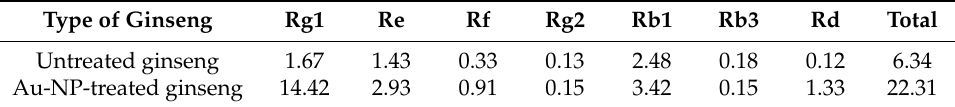
Table 1. Saponin contents in Au-NP-treated ginseng or untreated ginseng controls. Type of Ginseng Rg1 Re Rf Rg2 Rb1 Rb3 Rd Total Untreated ginseng 1.67 Au-NP-treated